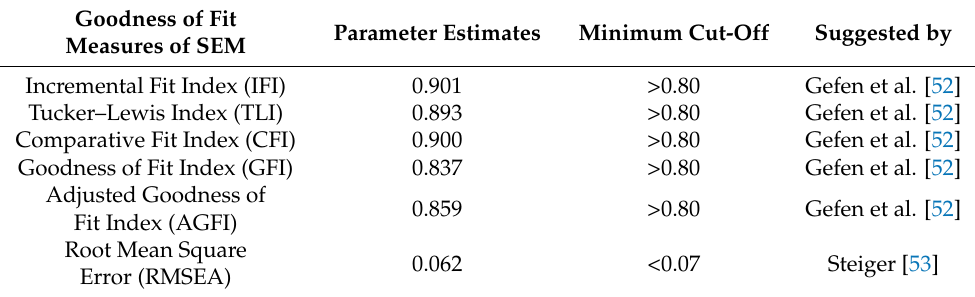
Table 4. Model fit.